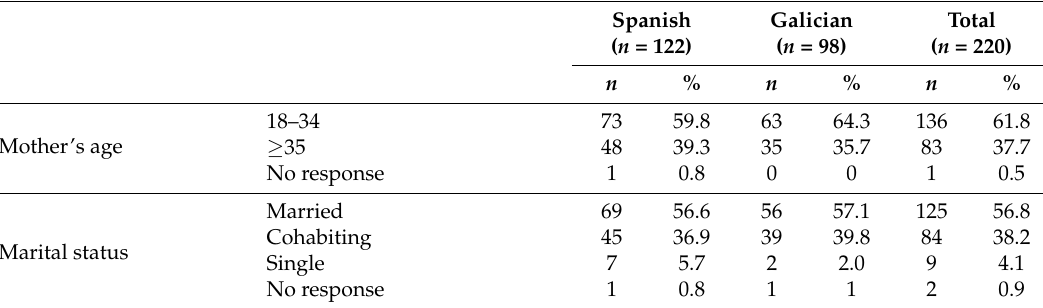
Table 1. Characteristics of the study population ( n =